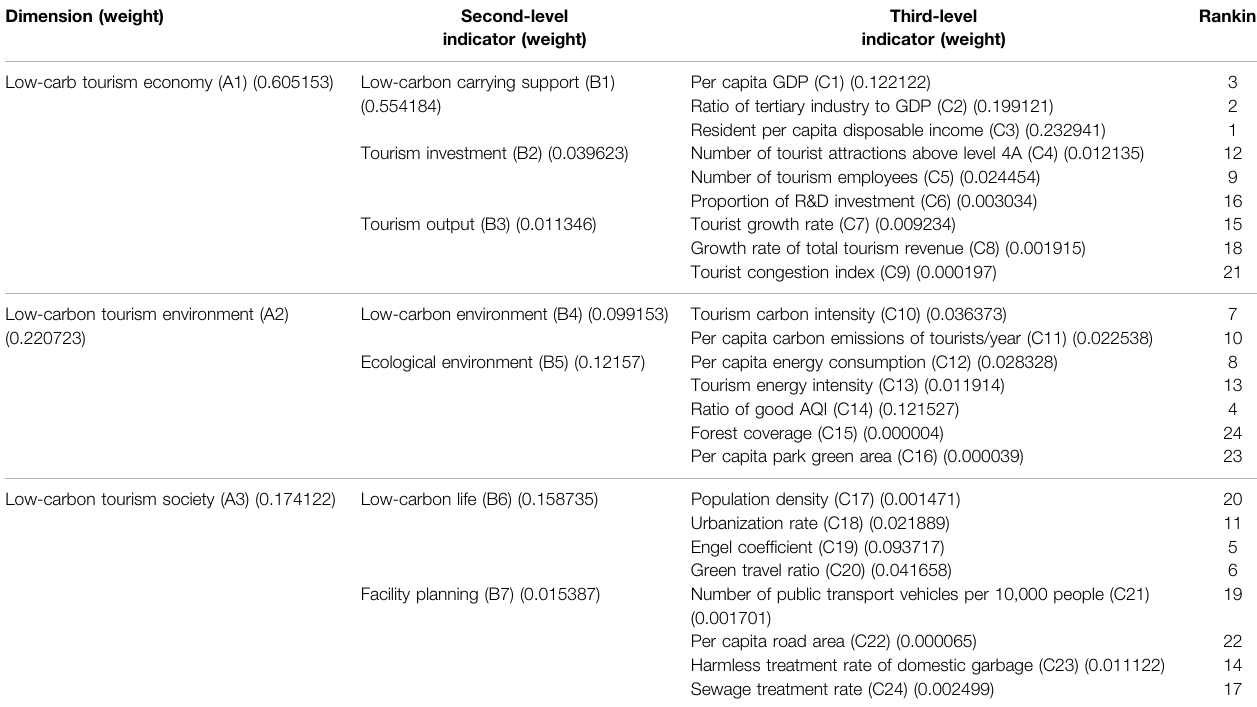
TABLE 6 | Results of weighted indicators. Dimension (weight) Second-level